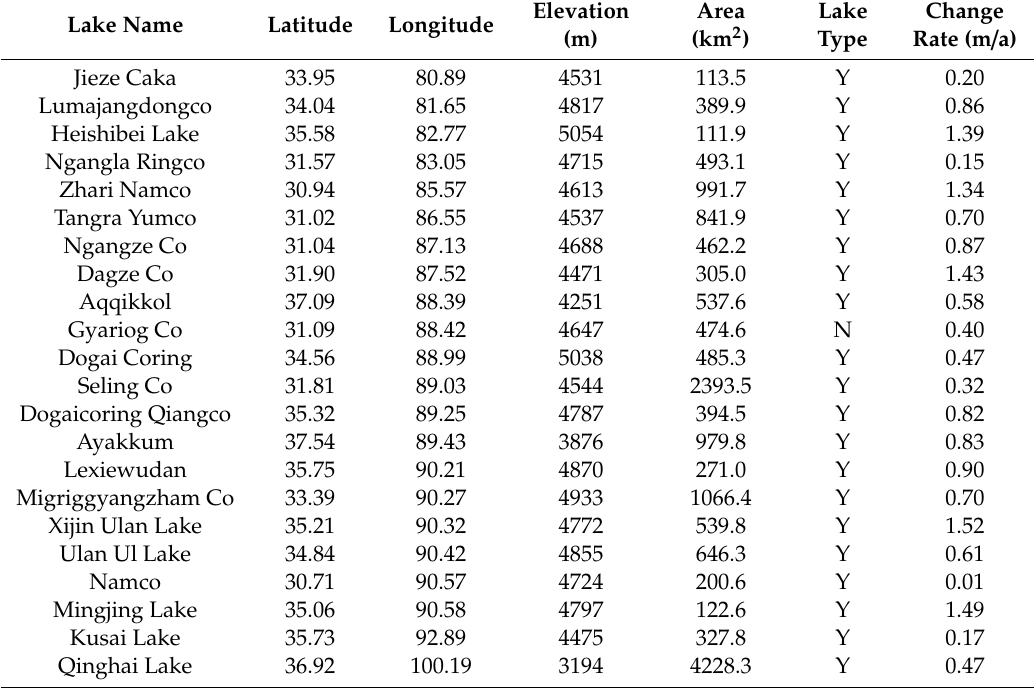
Table 3. Statistics of lake level changing rates in the Tibetan Plateau from 2016 to 2018 (“Y” represents terminal lakes and “N” open